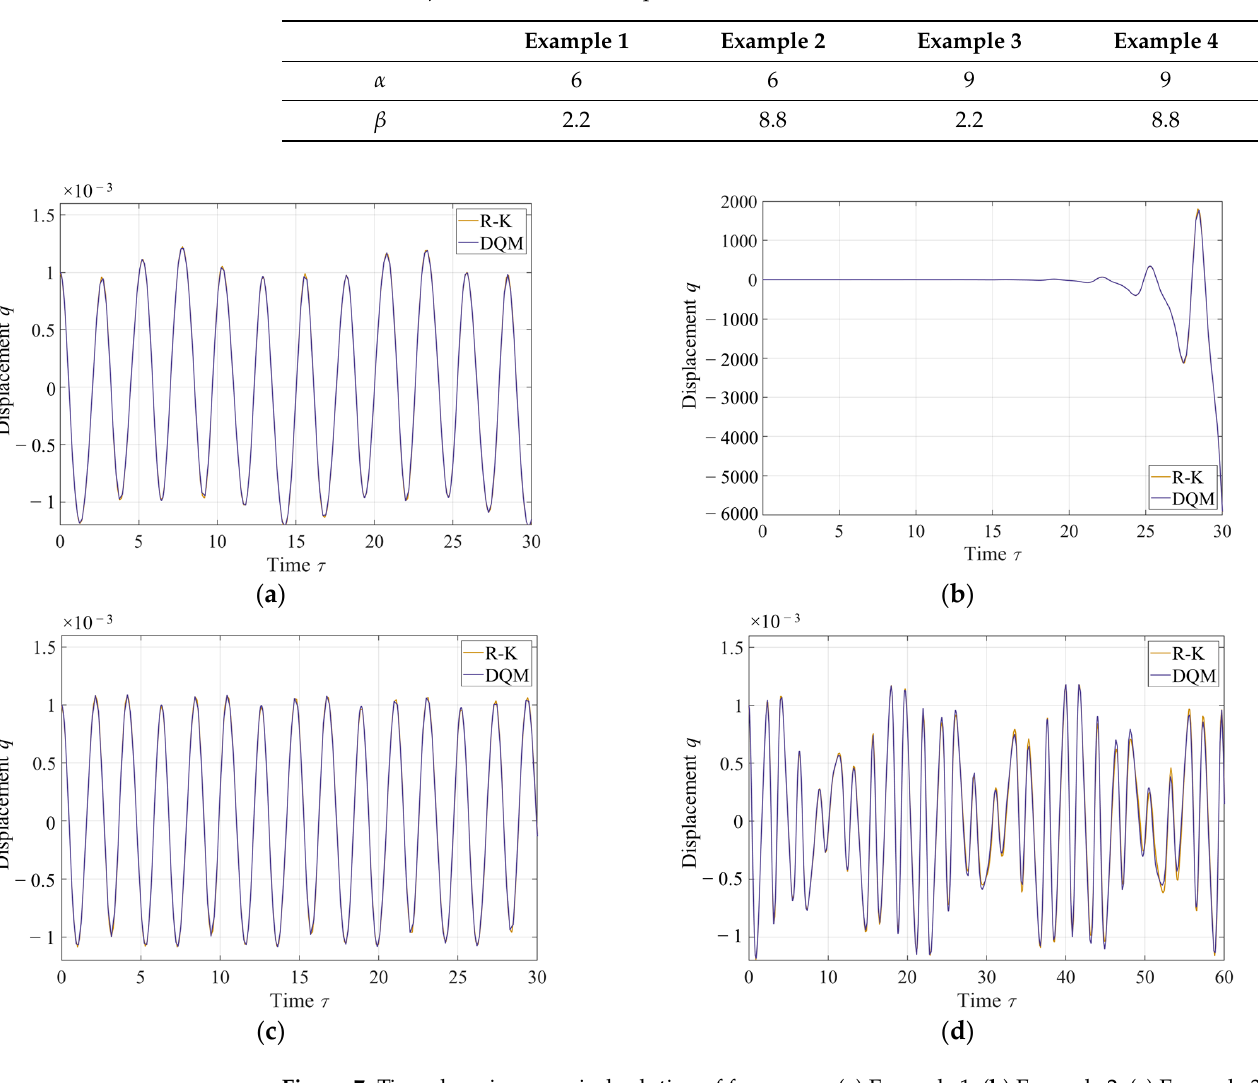
Figure 7. Time-domain numerical solution of four cases. ( a ) Example 1; ( b ) Example 2; ( c ) Example 3; and ( d ) Example 4.